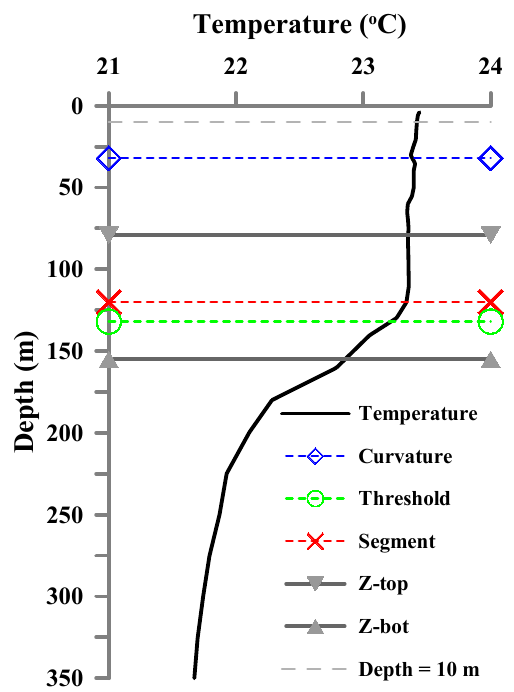
Figure 2. The MLD estimated for a sample temperature profile based on curvature, threshold, and segment methods. The Z-top and Z-bot respectively represent the top and bottom ends of the portion of the profile with significant